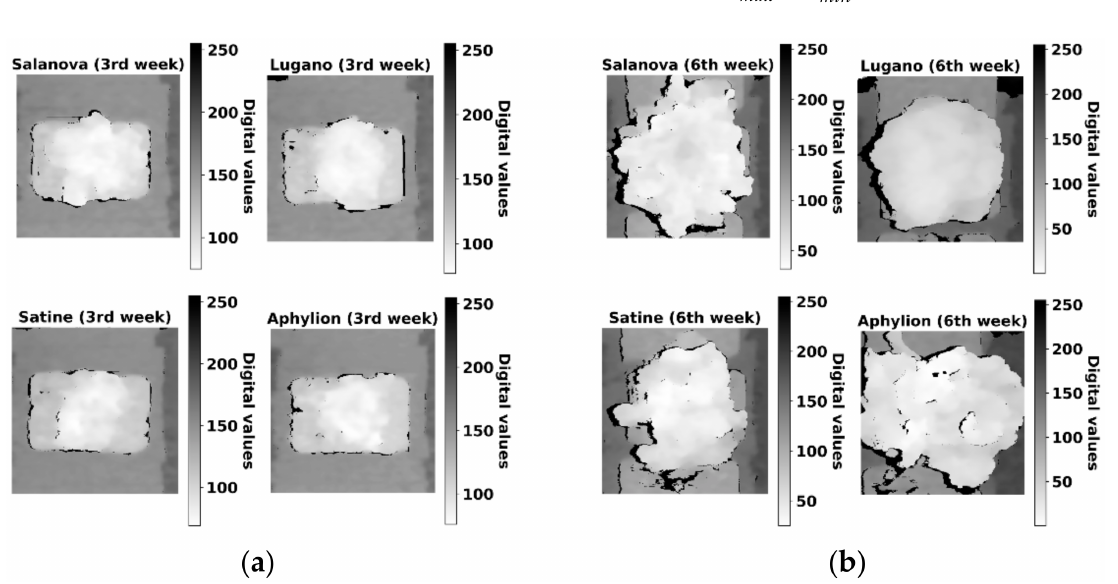
Figure 2. Normalized depth images with grayscale to visualize digital values from 681 to 1306 (high: close to the camera, low: far from the camera): ( a ) depth images of the four lettuce varieties 3 weeks after transplanting; and ( b ) depth images of the four lettuce varieties 6 weeks after transplanting. The normalized values were converted into a grayscale image. A value closer to zero indicates a closer distance between the plant and camera, and larger values indicate a farther distance between the plant and